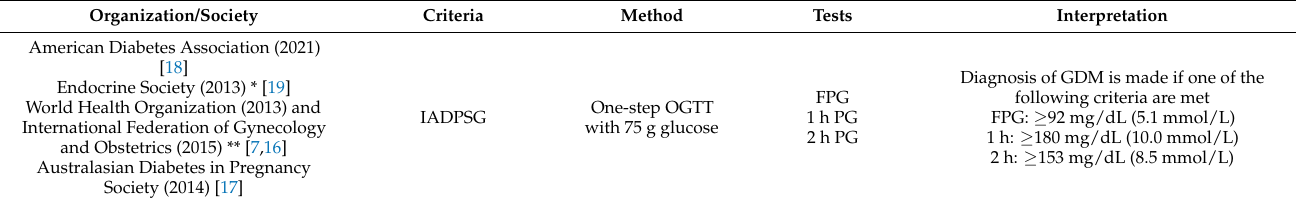
Table 1. Diagnostic criteria for GDM at 24–28